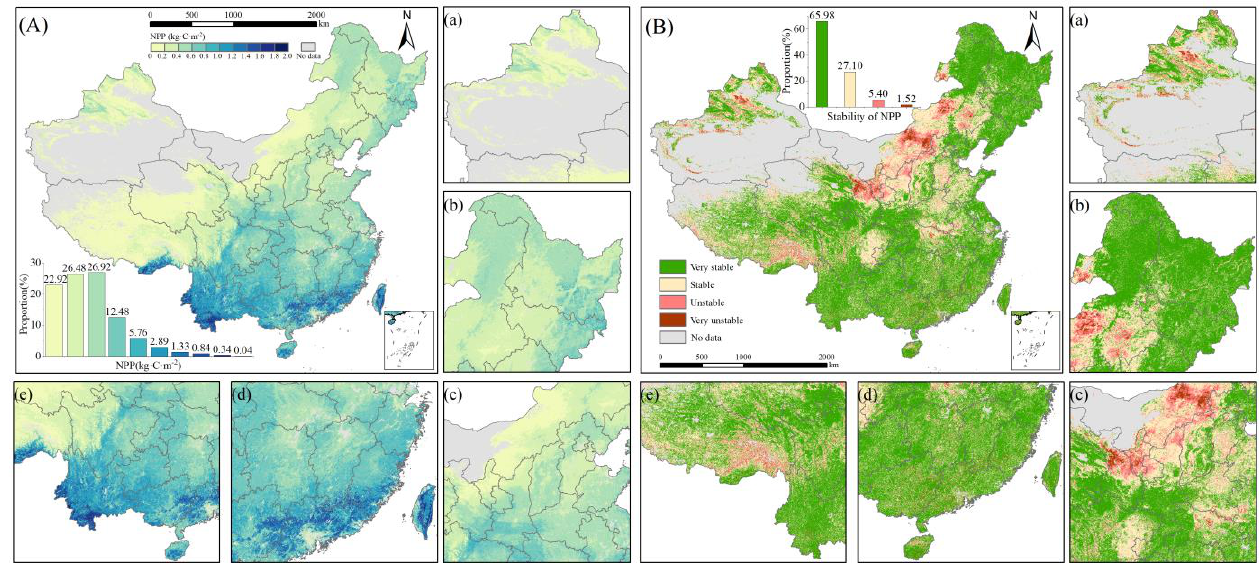
Figure 3. Spatial and stable patterns of NPP. (a)−(e) represent the detailed information for the northwest China, northeast China, Central China, southeast China and southwest China, respec-